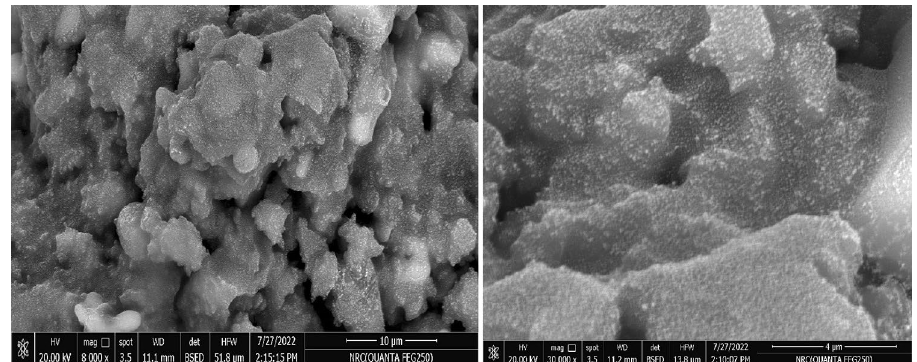
Figure 5. SEM images of PDMS/SiO2 nanocoating.